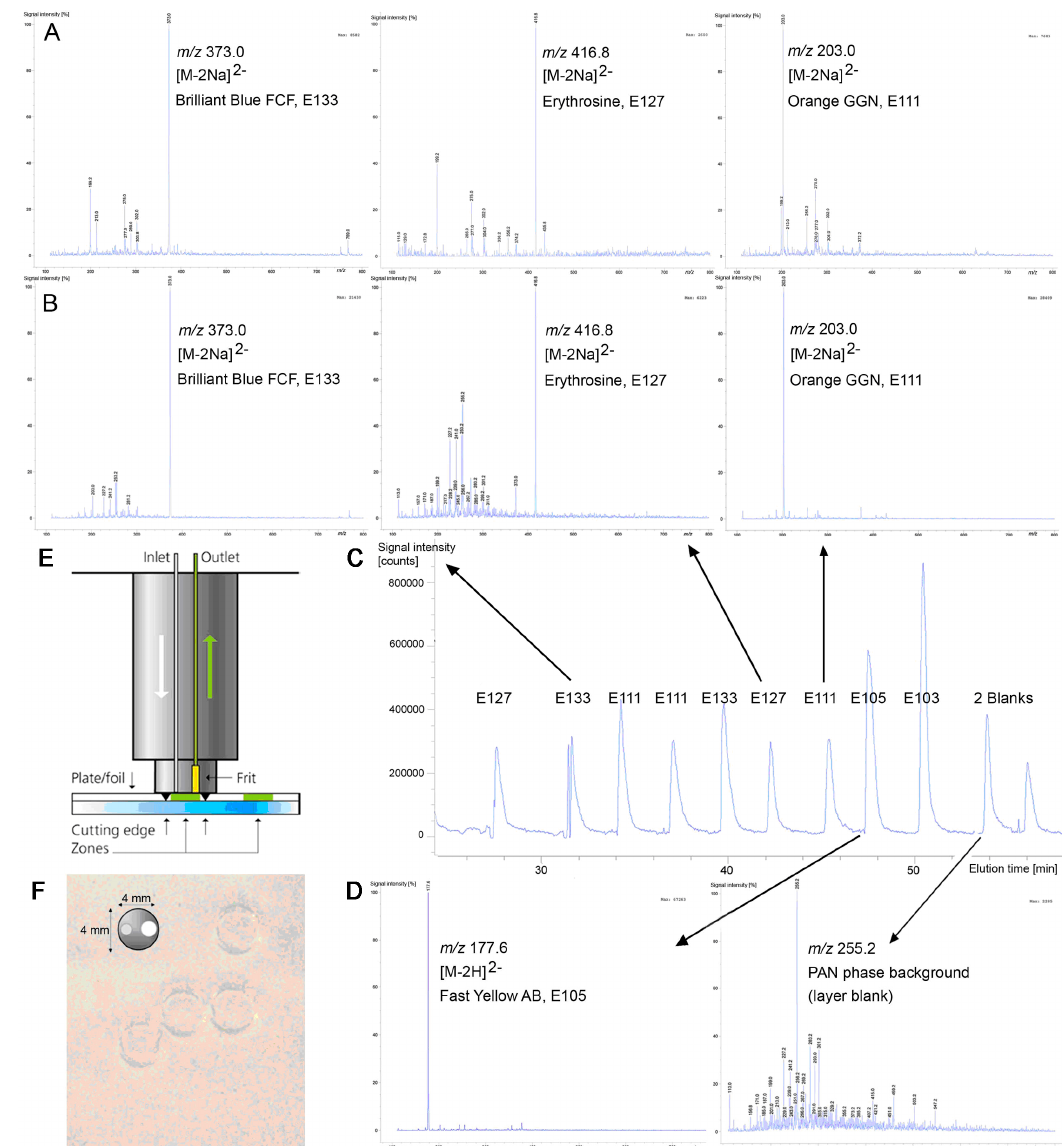
Figure 4. Comparison of HPTLC-ESI-MS spectra for E 133, E 127, and E 111 obtained from HPTLC foils silica gel 60 ( A ) with UTLC-Vis-ESI-MS spectra recorded from electrospun PAN nanofiber phases ( B ); chronogram of elution profiles ( C ) and mass spectra of E 105 and PAN phase background ( D ); scheme of the elution head ( E ) and some fiber mat imprints after elution on the electrospun PAN nanofiber phase ( F ).